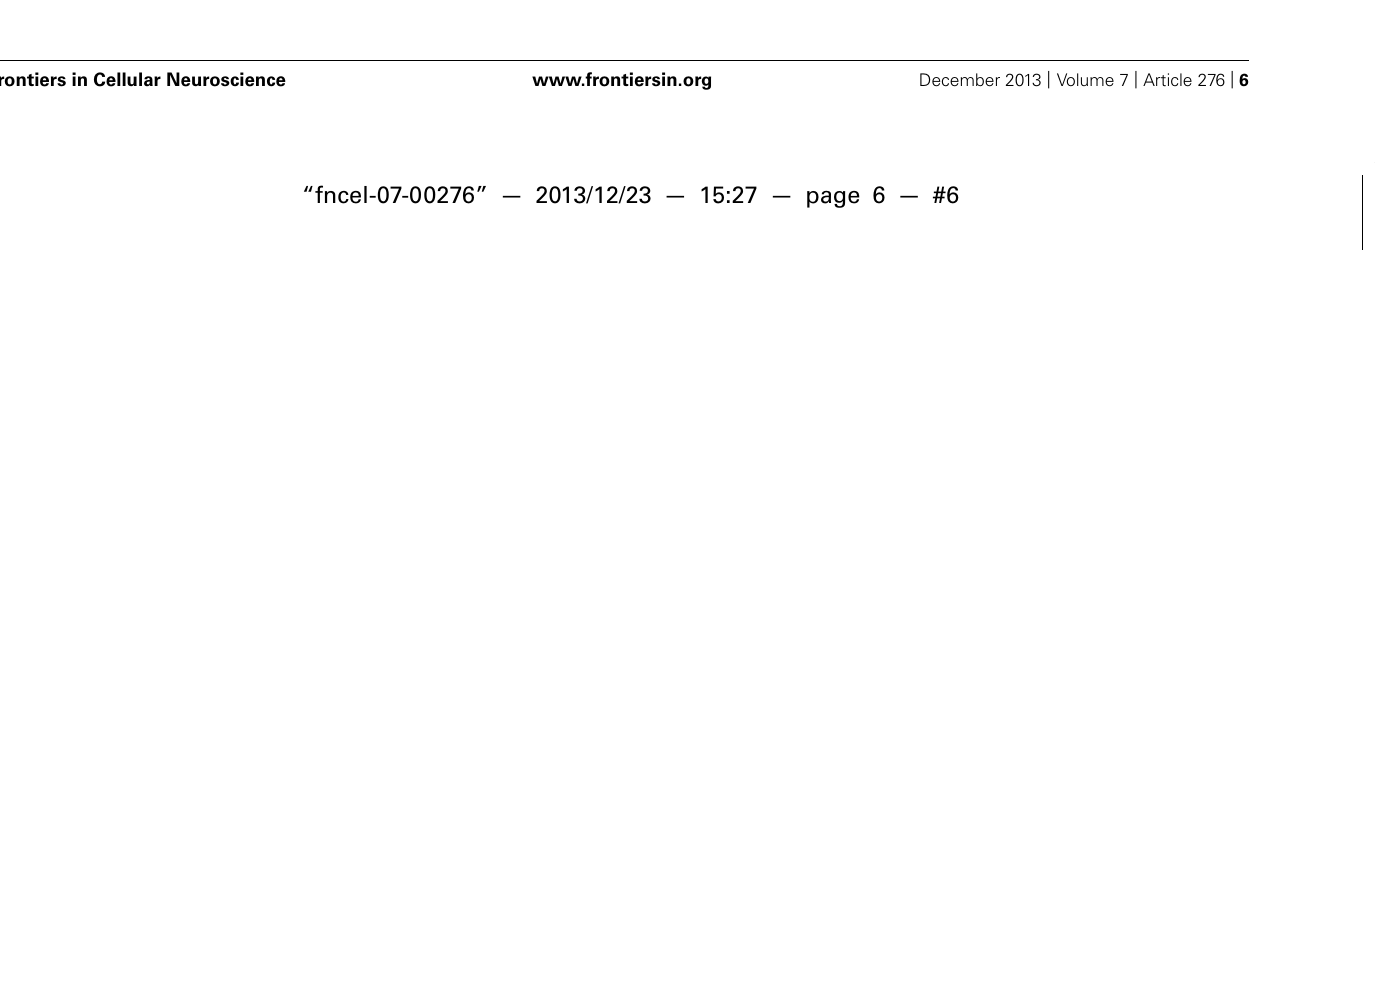
excitatory receptive field with a sub-threshold zone (1) and a firing zone (2). (C) Plateau-generating neuron that had a receptive field with excitatory (1, 2) and inhibitory (3) zones in response to innocuous (a) as well as noxious (b) mechanical stimuli. Note that the firing zone was larger to pinprick (b) than to brush (a)